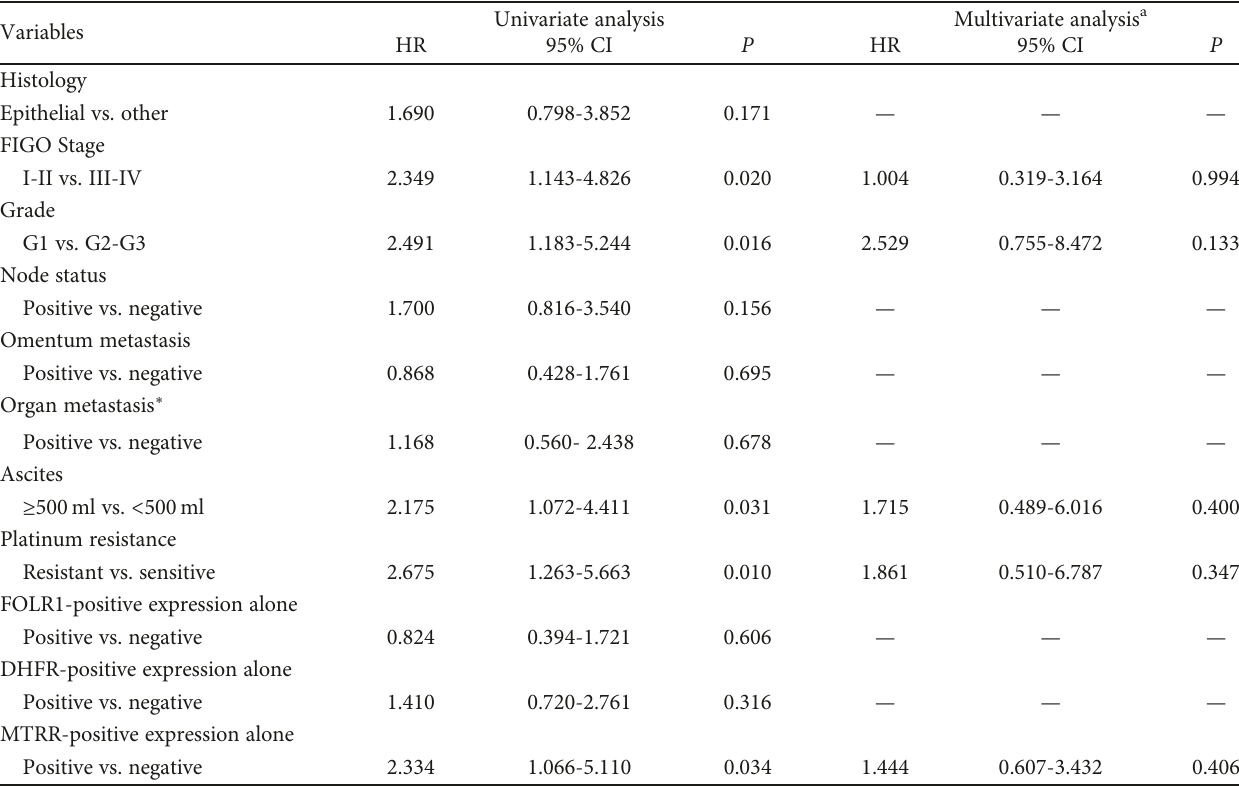
Table 5: Univariate and multivariate analysis of survival in 80 patients with